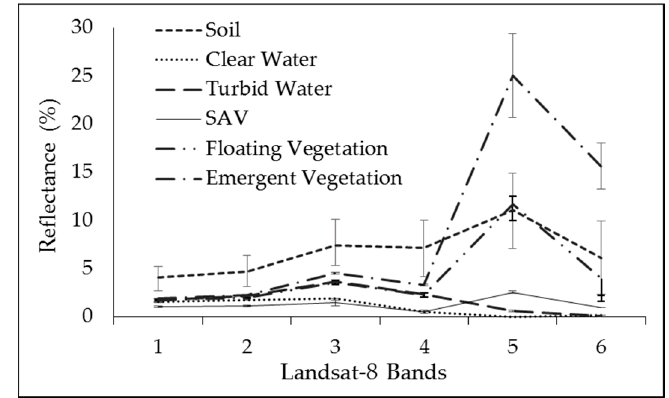
Figure 5. An endmember 2-D scatter plot derived from Minimum Noise Fraction (MNF)-transformed Landsat-8 images (Band 3 and Band 4). The manually selected pixels extracted from the image use the ground reference data for September 2014.